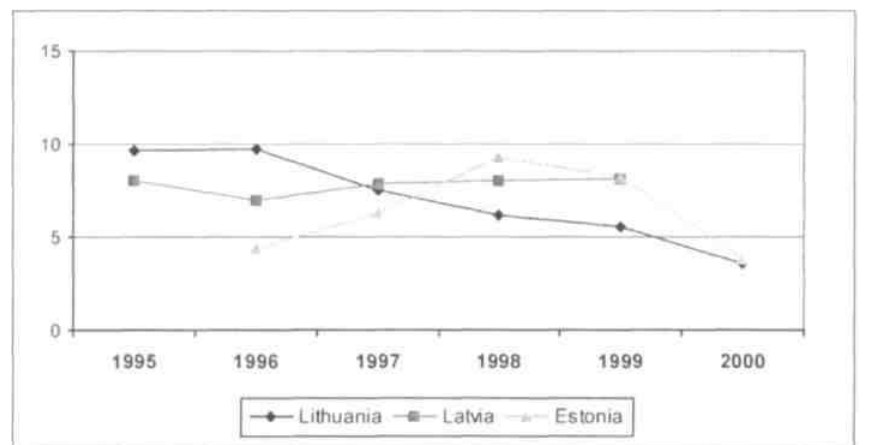
Fig 4. Share of corporate profit tax in national budgets of Lithuania, Latvia, Estonia [14], [15],